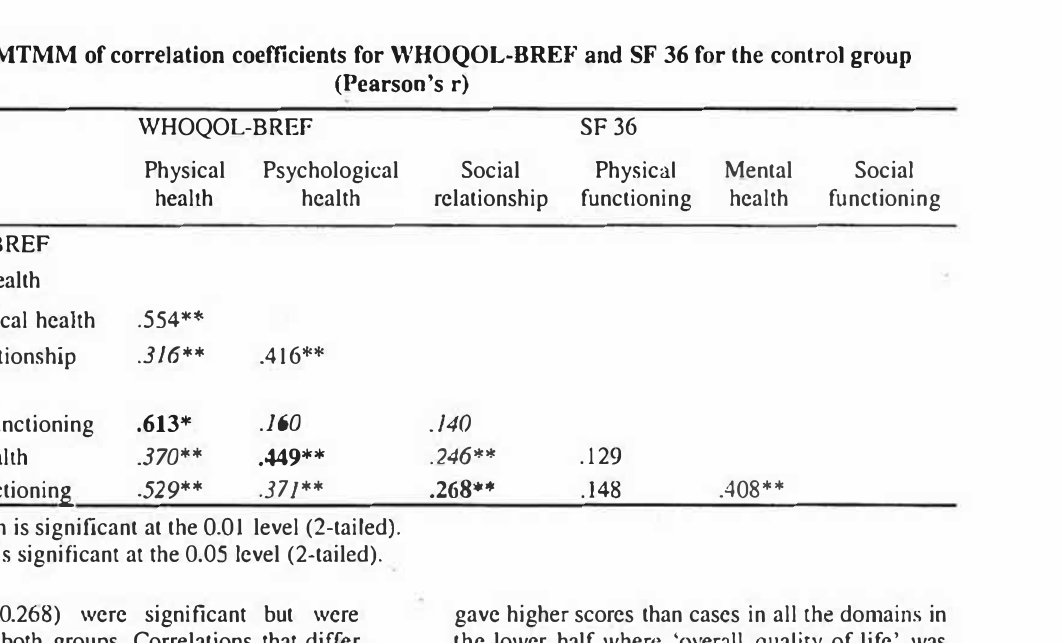
Table 2 - MTMM of correlation coefficients for WHOQOL-BREF and SF 36 for the control group